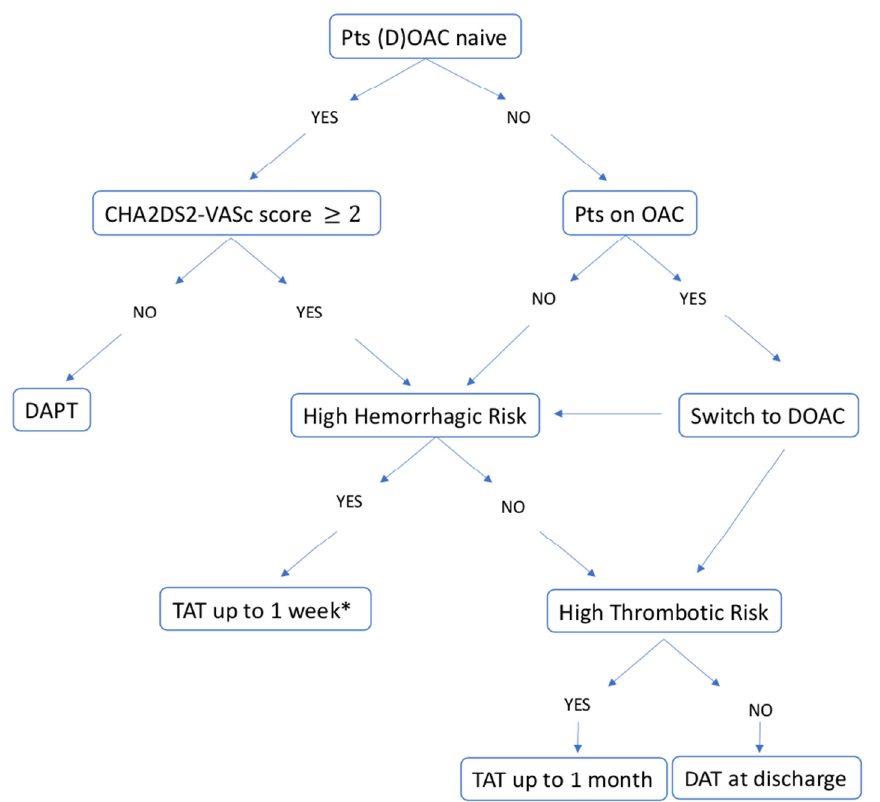
Figure 7. Proposed algorithm for the choice of antithrombotic strategy in patients with atrial fibrillation presenting with acute coronary syndrome and/or undergoing PCI. * evaluate continuation until hospital discharge. DOAC: direct oral anticoagulant; OAC: oral anticoagulant; TAT: triple antithrombotic therapy; DAT: dual antithrombotic therapy.